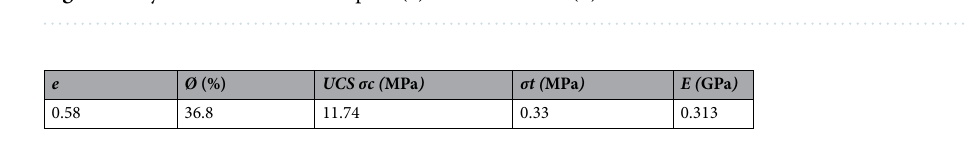
Figure 2. Synthetic carbonate samples. ( a ) Intact rock and ( b ) fractured rock.